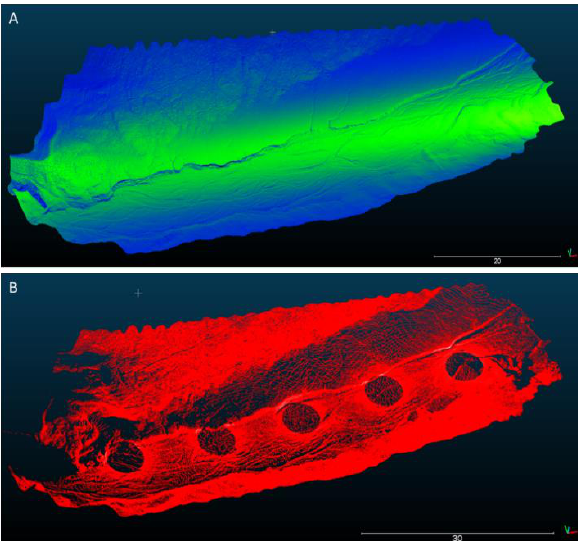
Figure 11. Simulated point clouds of the optimised UAV-borne VUX-1UAV (A) coloured by point density and terrestrial Riegl VZ-400 (B)